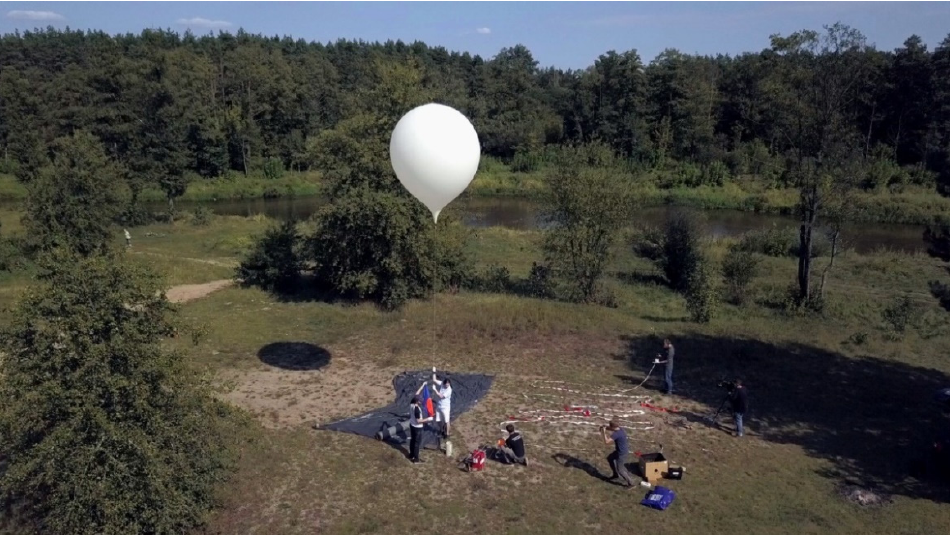
Figure 1. Final stage of a latex balloon launch, with a 40 m long antenna [5] prepared on the ground.